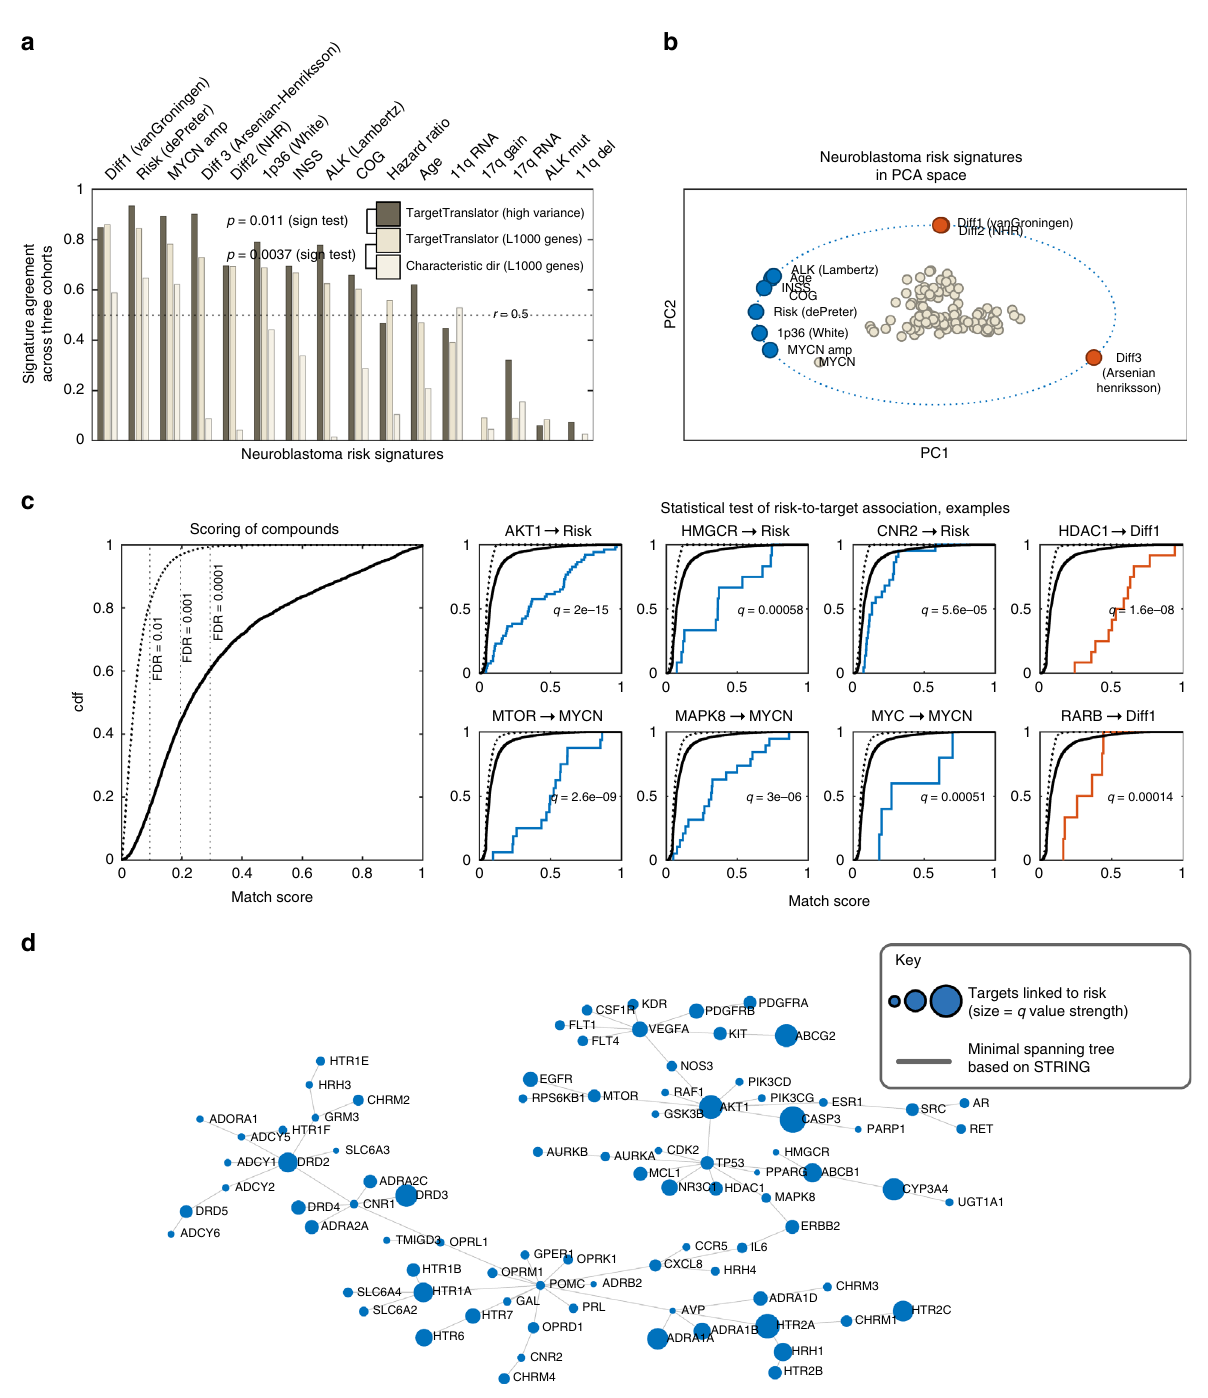
Fig. 2 Detection of multiple targets linked to neuroblastoma risk factors. a Validation of neuroblastoma risk signatures by each signature's agreement across three independent cohorts (R2, TARGET and SEQC). Dark grey = signatures constructed by TargetTranslator, using high variance genes; grey = TargetTranslator, L1000 landmark genes; white = L1000 landmark genes, using the Characteristic direction algorithm. b Principal component analysis of the 10 most reproducible signatures, showing risk factors at unit length and marker genes as points; note collinearity between signatures and the distinct/ opposing direction of differentiation signatures. Blue: signatures associated with disease pathways or poor outcome. Red: signatures associated with differentiation. c Left: Matching compounds and drugs in L1000 to neuroblastoma signatures; score empirical cumulative distribution function (ecdf) for 19763 drugs, based on L1000 from 14 cell lines (dashed line = permutation control). Right: Detection of enriched targets by shifts in the ecdf curve. L1000 compounds were mapped to drug targets using the STITCH database. Examples of drugs with a common target are highlighted (coloured curve). Note examples of con fi rmed ( AKT1, MTOR, HDAC1 ), predicted ( HMGCR, MAPK8, CNR2 ) and control targets ( MYC, RARB , associated to MYCN and differentiation signatures, respectively). q are FDR-controlled p -values of a Kolmogorov – Smirnoff test that compares target-speci fi c compounds (coloured curve) vs other compounds. d Visualization of pathway dependencies for all targets with q -value < 0.0001, mapped to the minimal spanning tree (MST) of all STRING links between targets. (MST facilitates visualization, by removing redundant